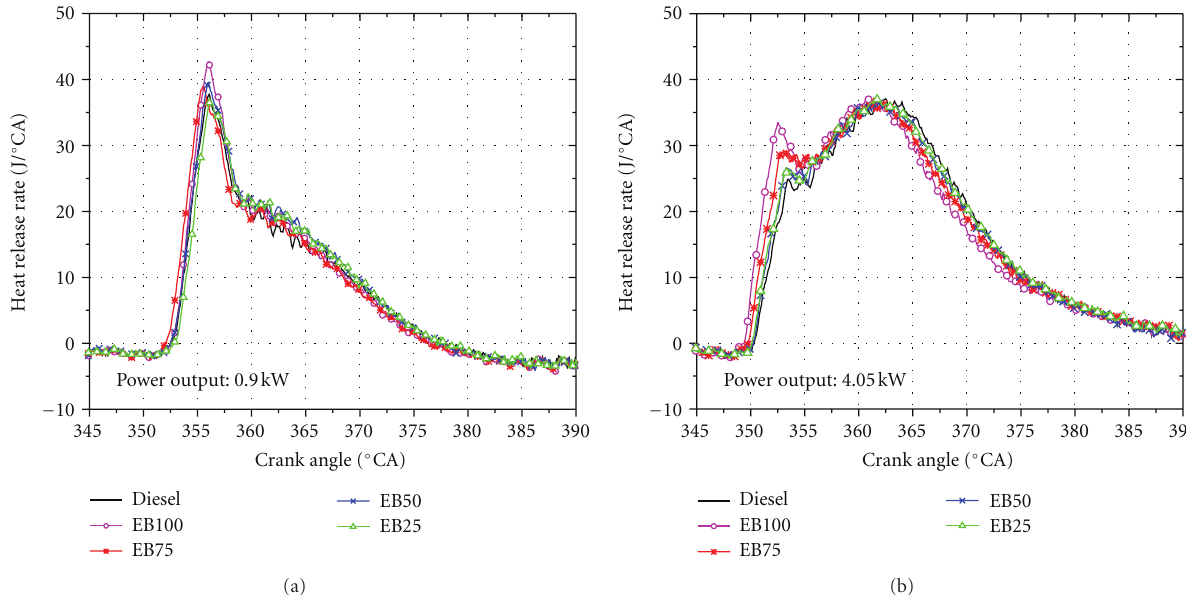
Figure 4: Heat release rate at various power outputs.